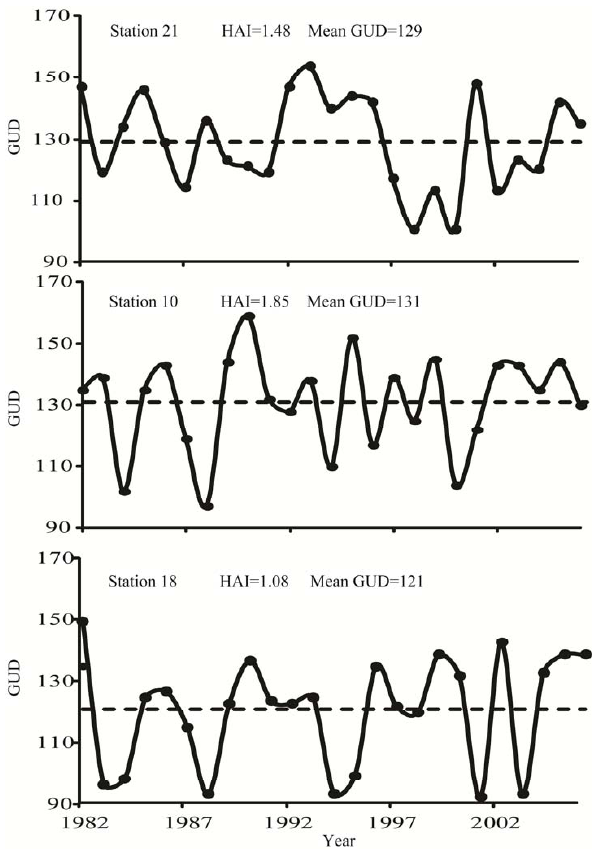
Fig. 5. Temporal pattern of Green-up Onset Date (GUD) at stations numbered 21, 10, and 18.